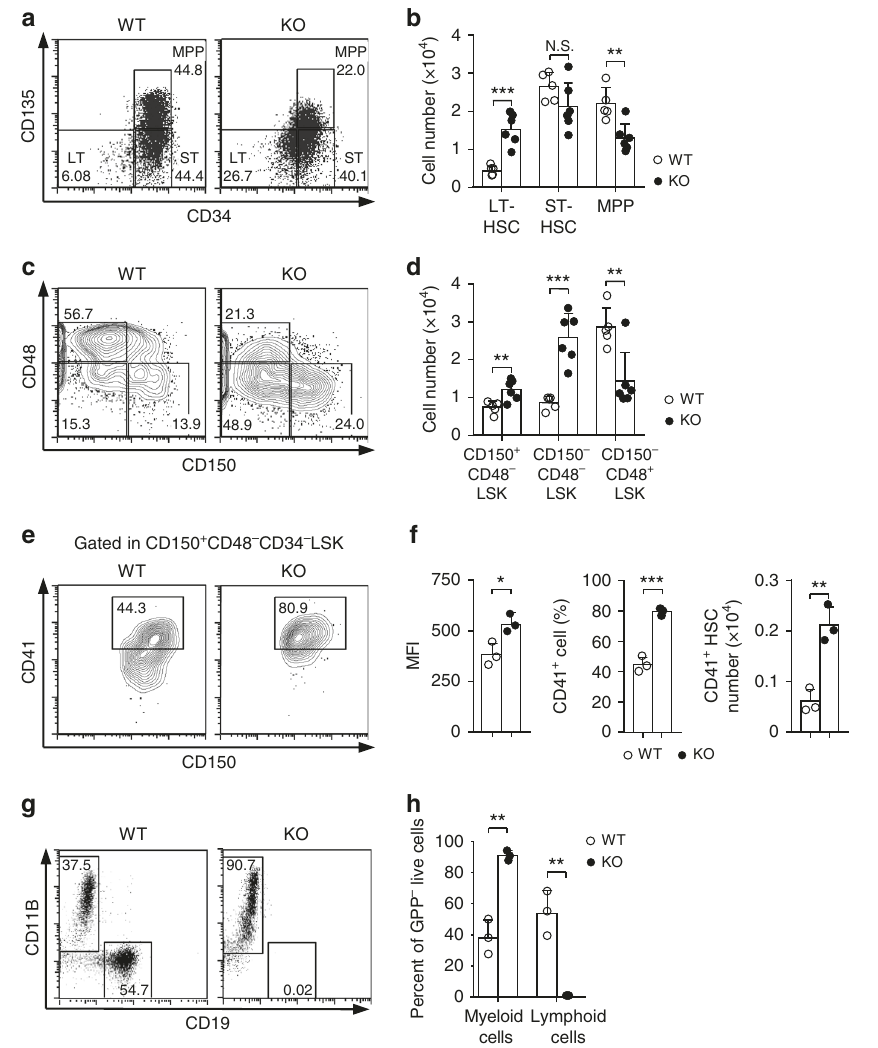
Fig. 3 Med23 -de fi cient HSCs harbor enhanced myeloid potential. a , b Representative dot plots gating from LSK ( a ) and absolute cell numbers ( b ) of LT-HSC (CD34 − CD135 − LSK), ST-HSC (CD34 + CD135 − LSK) and MPP (CD34 + CD135 + LSK) from WT and KO mice (WT, n = 5; KO, n = 6). c , d Representative contour plots gating from LSK ( c ) and absolute cell numbers ( d ) of HSC (CD150 + CD48 − LSK), CD150 − CD48 − LSK, and CD150 − CD48 + LSK from WT and KO mice using SLAM code (WT, n = 5; KO, n = 6). e Representative contour plots showing CD41 expression within HSCs in WT and KO mice. f Mean fl uorescence intensity (MFI) of CD41 expression in HSCs (left), percent of CD41 + population (middle) within HSCs, and cellularity of CD41 + HSCs (right) in the bone marrows of WT and KO mice ( n = 3). g Representative FACS plots gating from live cells of WT HSCs and Med23-de fi cient HSCs co-cultured with OP9 cell line on day 12. h Percent of myeloid cells (CD11b + ) and lymphoid cells (CD19 + ) differentiated from WT HSC and Med23-de fi cient HSC co-cultured with OP9 cell line ( n = 3). The data are means ± S.D., for all panels: * p < 0.05, ** p < 0.01, *** p < 0.001 by Student ’ s t -test, N.S. no signi fi